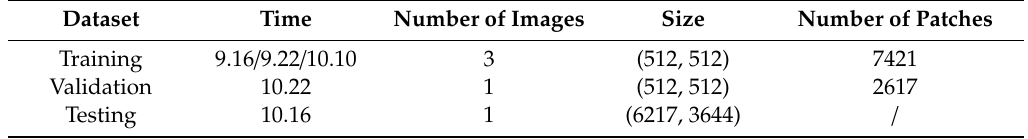
Table 1. Training, validation, and test data of the experiments.